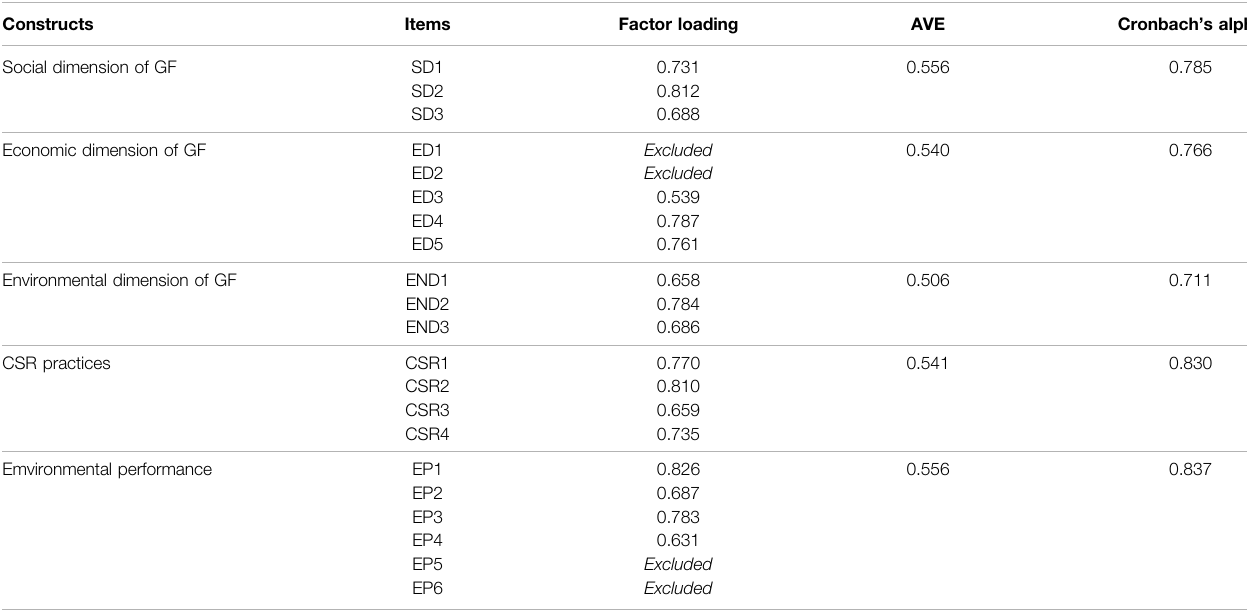
TABLE 3 | Convergent validity of survey